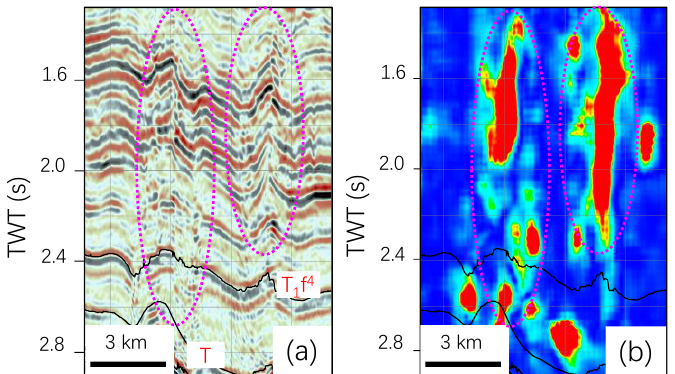
Figure 6. ( a ) The original seismic profile (T 1 f 4 : the fourth member of Feixianguan Formation of the Lower Triassic; T: base of the Triassic), and ( b ) the steerable pyramid attribute profile in the western Kaijiang-Liangping Trough (the red-green color area shows the fault damage zone, and the blue area shows the host rock).